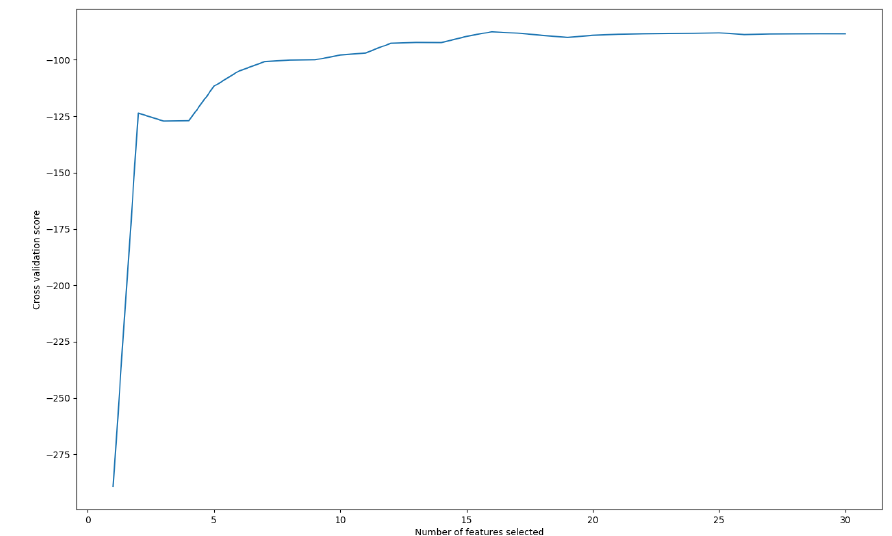
Figure A2. Cross-validation scores against the number of features selected by RFECV (see Sect. 2.4.3).